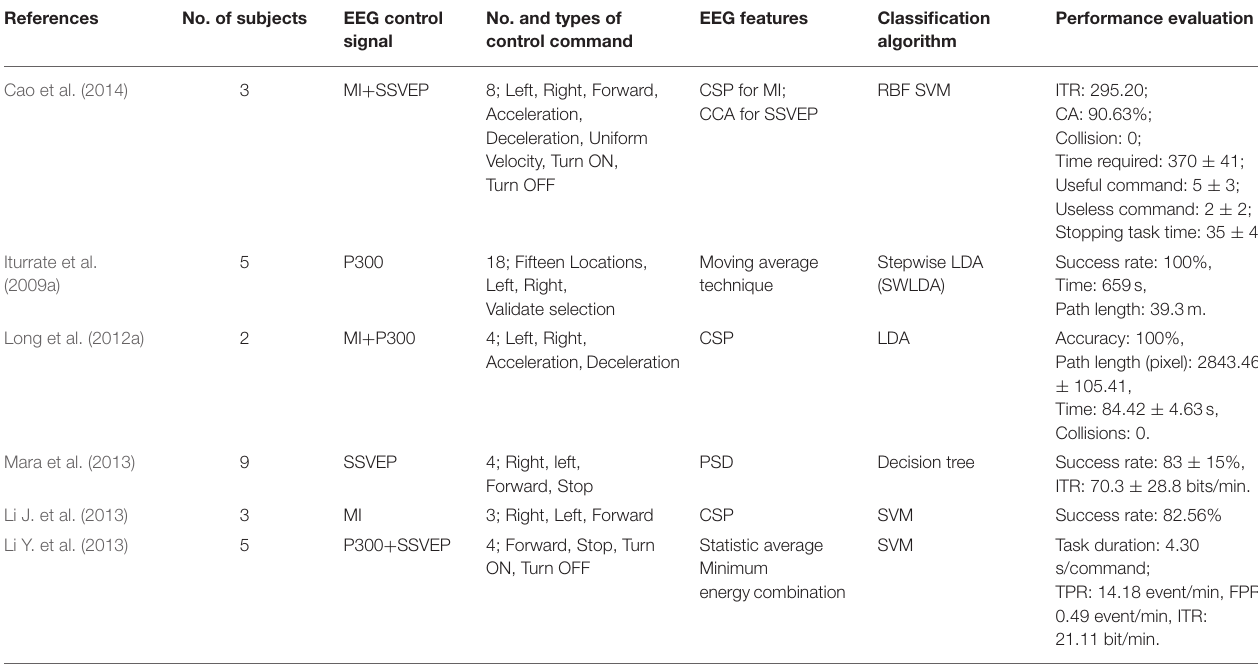
TABLE 3 | Summary of EEG-based BCI wheelchair studies.